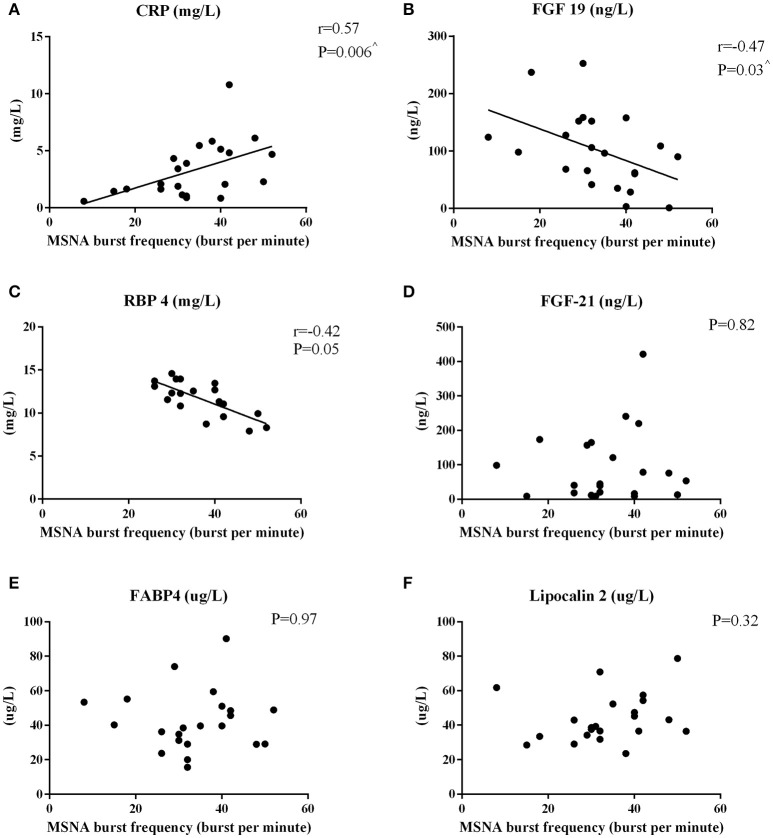
Pearson's Correlations between MSNA burst frequency and circulating hepatokines in men. The correlations between MSNA burst frequency and hsCRP (A), FGF-19 (B), RBP4 (C), FGF-21 (D), FABP4 (E), and lipocalin-2 (F) are reported. ∧P < 0.05 after adjusting for total body fat.